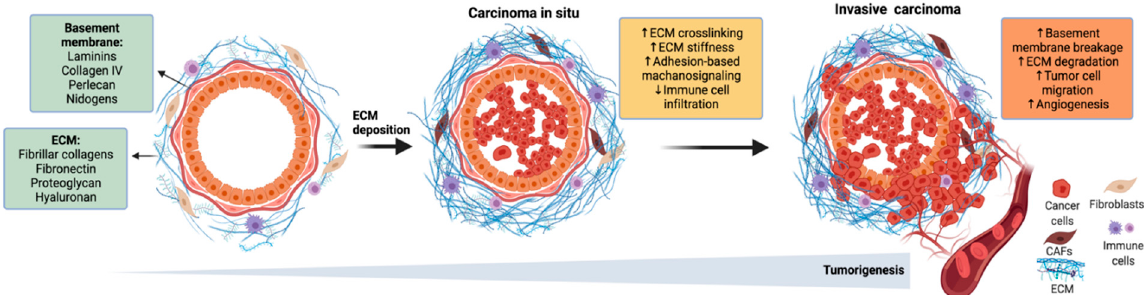
Figure 1. ECM remodeling in breast cancer progression and metastasis.